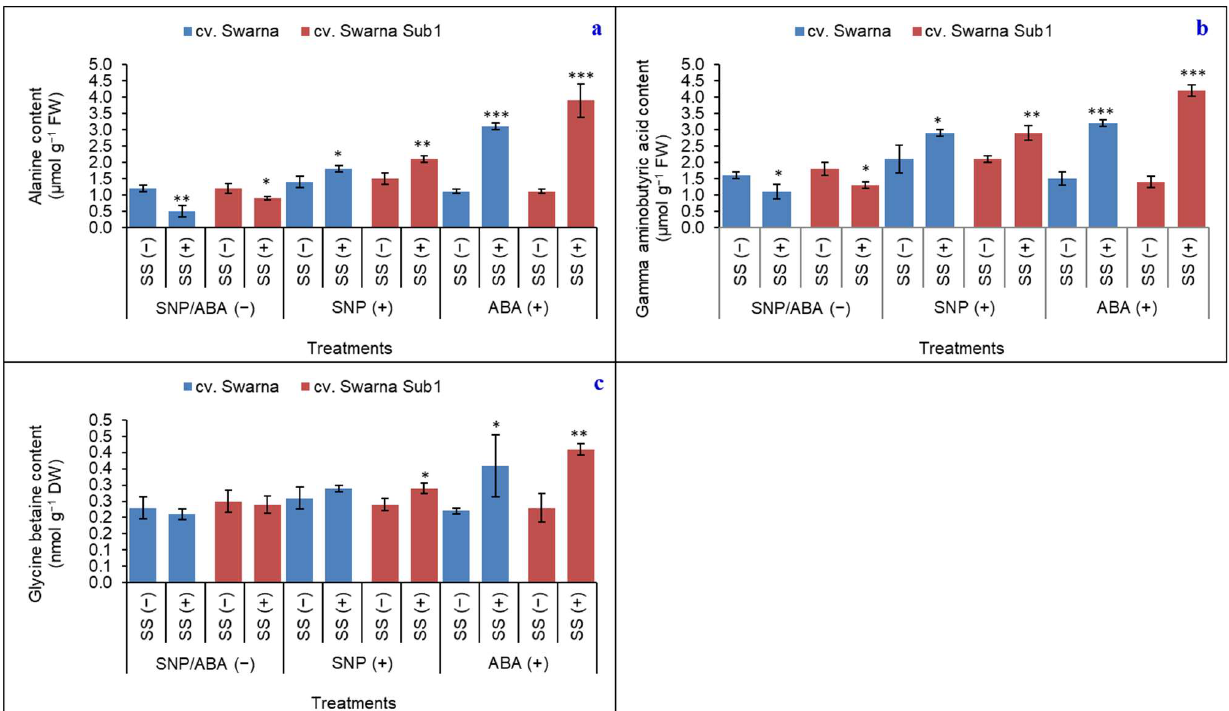
Figure 4. Changes in alanine ( a ), gamma aminobutyric acid ( b ) and glycine betaine ( c ) contents in two rice genotypes (cv. Swarna and Swarna Sub1) under salinity stress [SS (+)] and non-salinity stress [SS (−)] for 72 h with [SNP (+) or ABA (+)] or without [SNP/ABA (−)] priming for 24 h. Data are presented in bars with mean ± SE ( n = 3) from independent experimental sets and the significant values are represented as * ( p ≤ 0.05), ** ( p ≤ 0.01) and *** ( p ≤ 0.001) by student’s t -test to denote the significant difference between SS (−) and SS (+) of SNP/ABA (−), as well as SNP (+) and ABA (+) of each rice genotype.